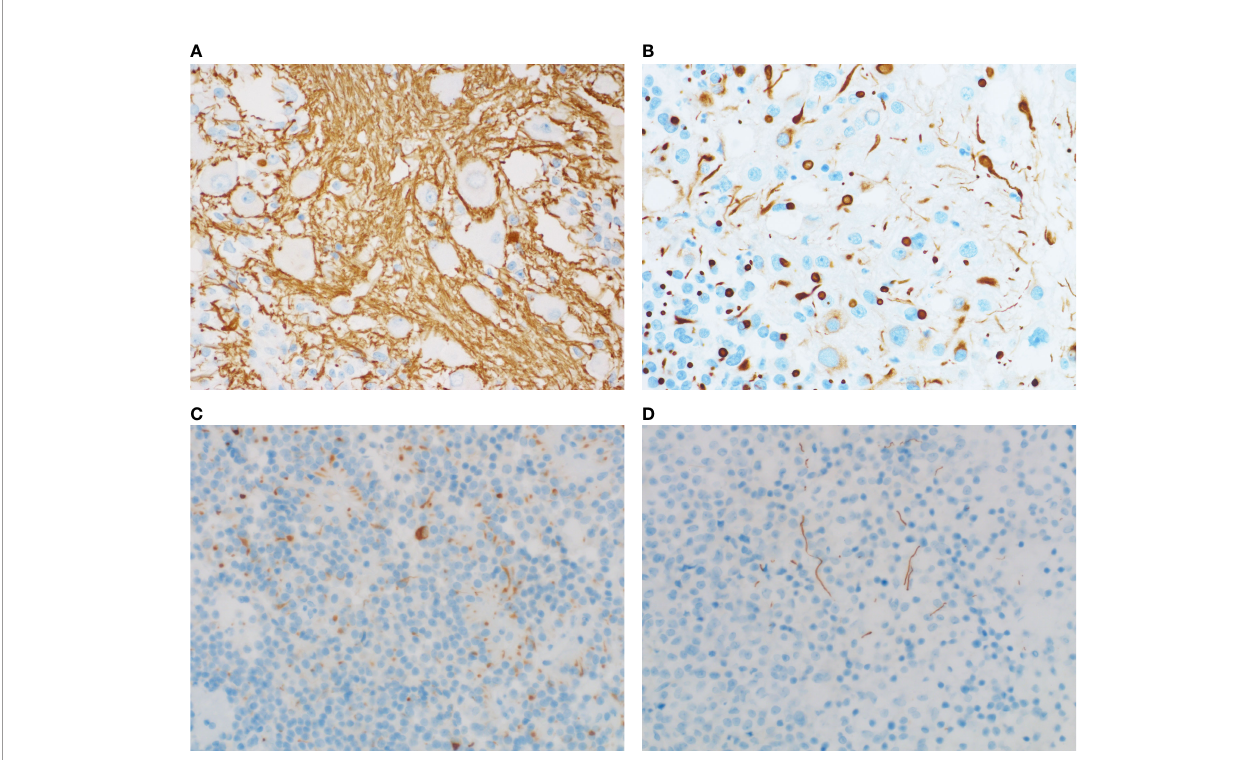
FIGURE 4 | NF staining and CK staining of adenomas with or without neuronal differentiation. (A) NF immunostaining shows axotomy-like expression. (B) Prominent CK8 staining is noted within fi brous bodies of the ganglion cells. (C) NF staining shows a dot-like/cytoplasmic staining pattern. (D) Axotomy-like NF coloring can also be seen in adenomas without ganglionic cells. [ (A – D) , magni fi